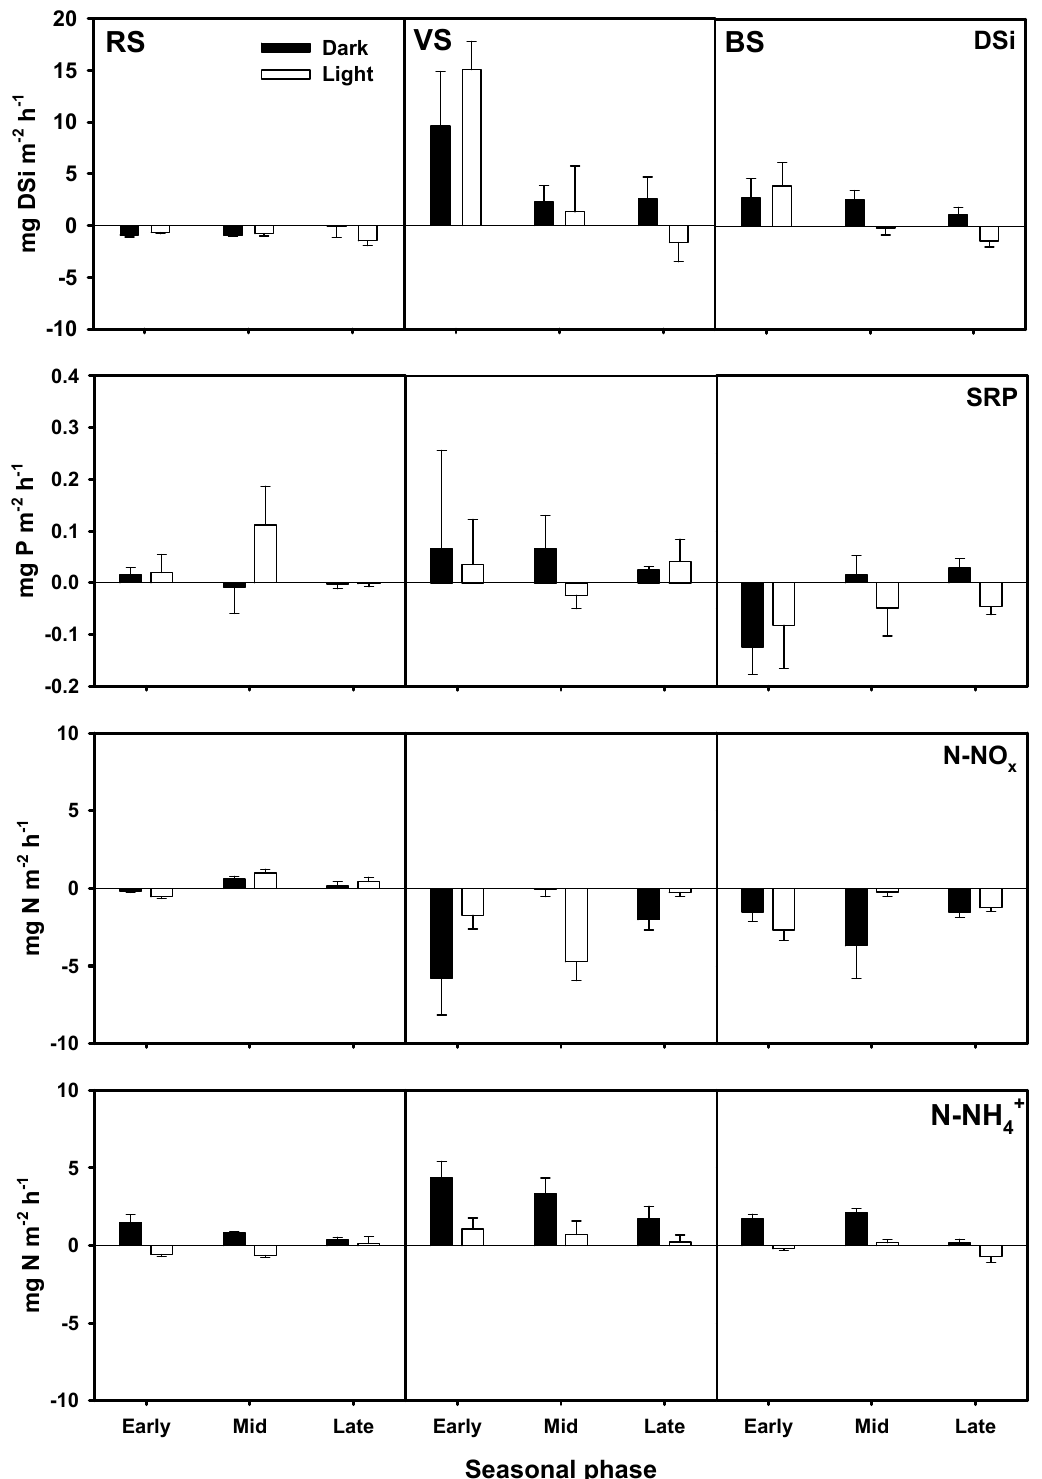
Figure 4. Light and dark fluxes of dissolved silica (DSi), soluble reactive phosphorus (SRP), nitrate and nitrite (N-NO x ), and ammonium (N-NH 4+ ) measured in the three sampling sites at the different dates. Error bars represent standard error (n = 6). Legend: RS = rocky shores; VS = vegetated sediments; BS = bare sediments.